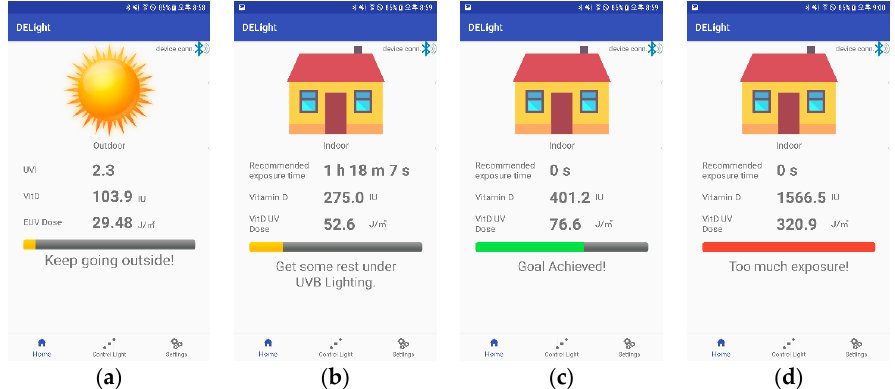
Figure 5. Mobile App on Notice: ( a ) outdoor; ( b ) indoor; ( c ) indoor, vitamin D sufficient; ( d ) when erythemal UV dose exceeds minimum erythemal UV dose.